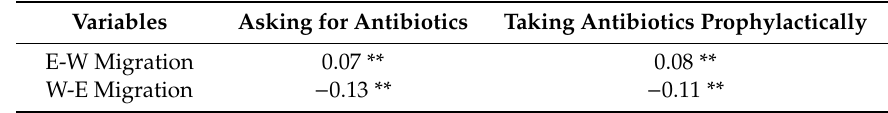
Table 3. Correlation coe ffi cients between migration and antibiotic use behaviors among university